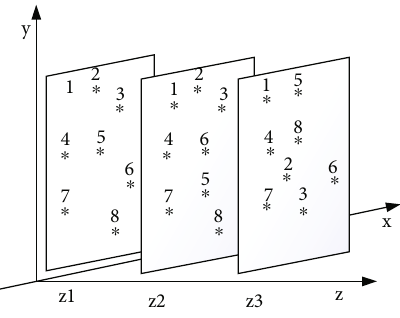
Figure 3: Schematic diagram of the three-dimensional